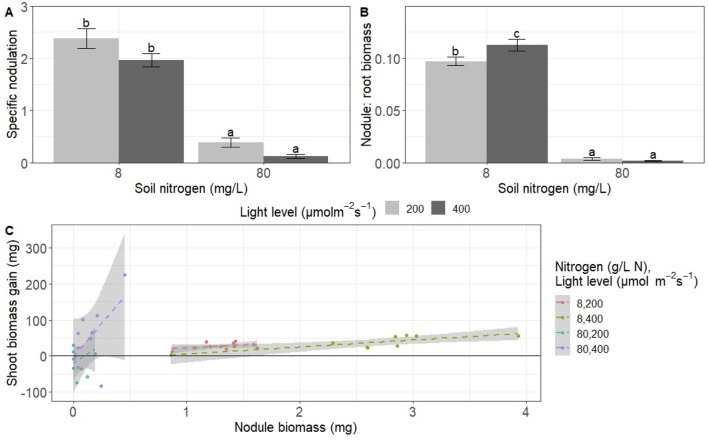
Effects of light and nitrogen on investment in trade versus direct uptake and return on investment in trade. (A) Specific nodulation (nodule number per milligram root biomass), (B) nodule:root biomass (mg nodule biomass per mg root biomass), and (C) symbiosis efficiency mg shoot gained per mg invested in rhizobia). Each point represents an individual plant (8–11 replicates). Bars with the same letter within a panel do not significantly differ after Tukey post hoc testing (P > 0.05).